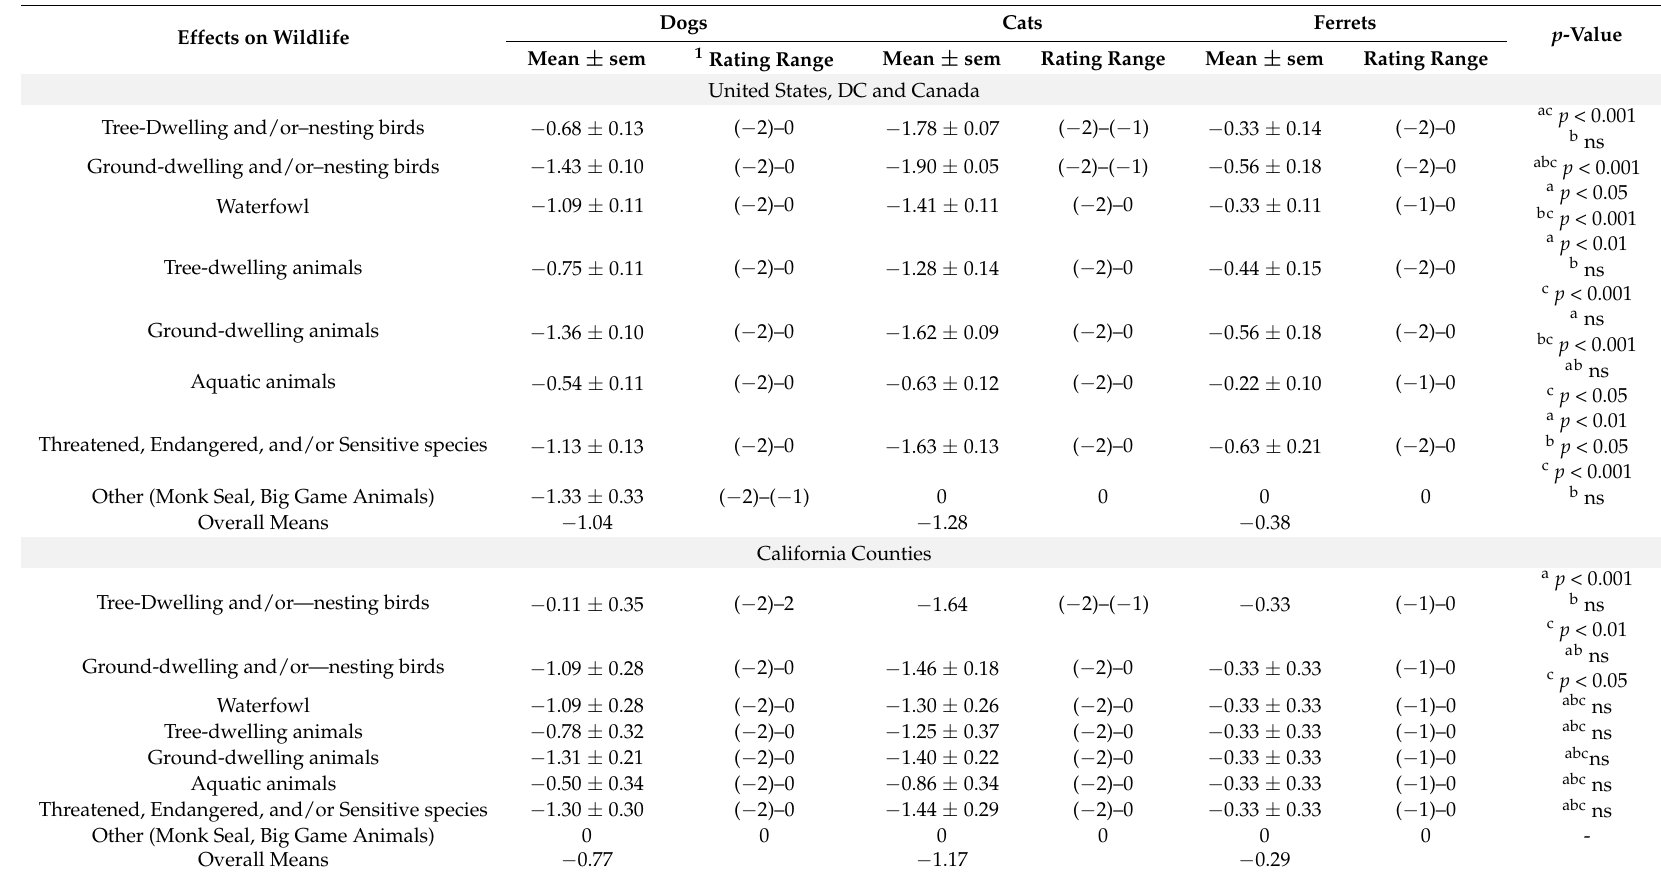
Table 3. “Degree of concern” regarding the effects (impact) of unconfined animal on